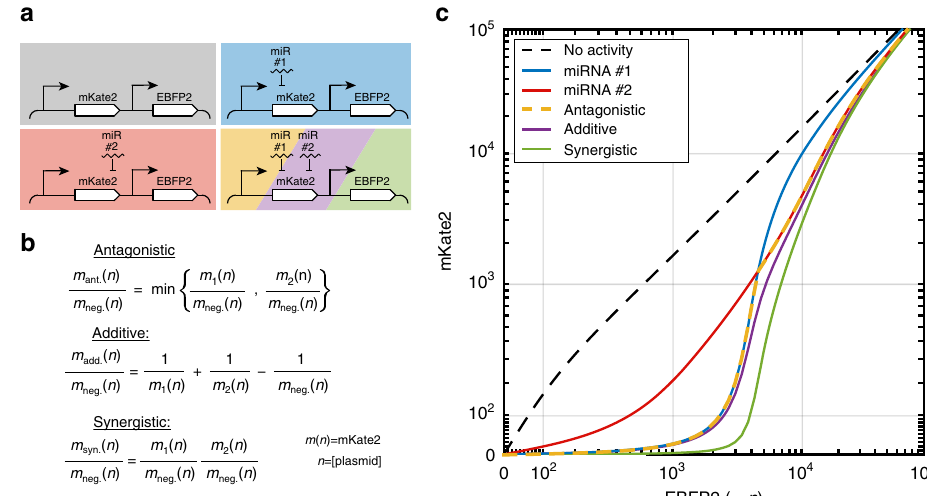
Fig. 2 Methods for combining miRNA activities in predictions of 2-input low sensors. a Schematics for 0-input control (gray), 1-input (blue and red), and 2- input miRNA sensors (yellow/purple/green stripe). The 1-input miRNA sensors are fi rst characterized, and the characterization used to predict the behavior of multi-input sensors. b Equations based on the Chou – Talalay method adapted here for predicting miRNA activity of 2-input sensors according to antagonistic, additive, and synergistic interactions. Predictions of free mKate2 mRNA concentration for the three interaction types ( m ant. ( n ), m add. ( n ), and m n )) are computed based on the characterized output of miRNA 1 ( m n )) and miRNA 2 ( m n )). All mKate2 mRNA concentration predictions are syn. ( 1 ( 2 ( functions of the number of plasmids ( n ) in the cell, which is proportional to EBFP2 fl uorescence. m neg. ( n ) refers to the output of the negative control where no miRNA target sites are present. General equations for cases with more than two miRNA inputs are presented in the Supplementary Note 1. c Calculation of 2-input predictions from single-input activity. Colors for the curves correspond with those from a . The repression curve for the negative